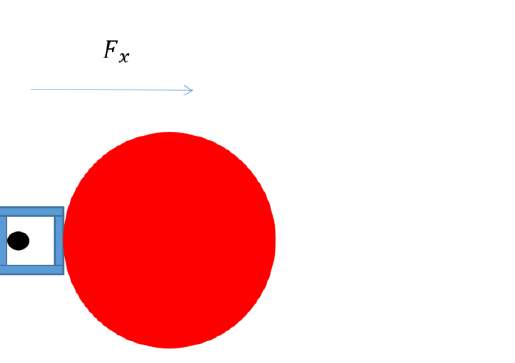
Figure 9. Profile AUV stress in the horizontal direction, F x is the force of the water flow in the horizontal direction .